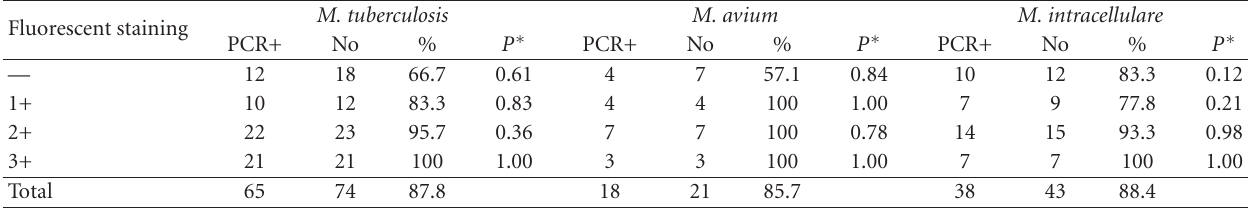
Table 4: M. tuberculosis , M. avium , and M. intracellulare PCR positivity rates according to fluorescent staining from Jan 2005 to Mar 2007. Fluorescent staining